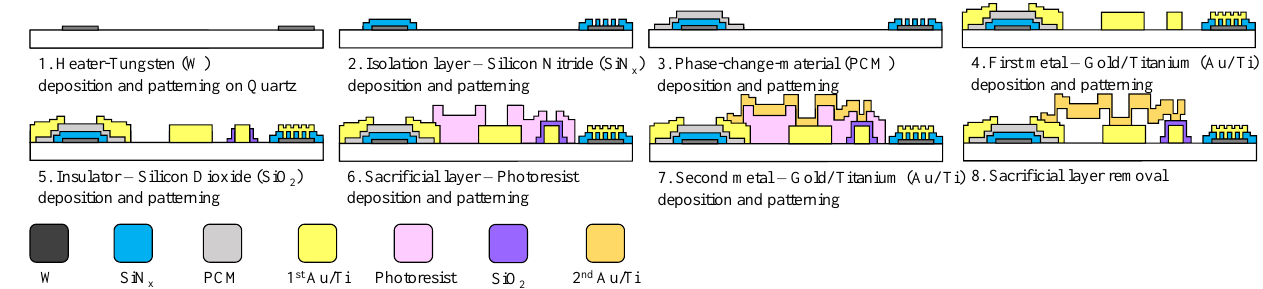
Figure 4. Our proposed standard PCM-based fabrication process.